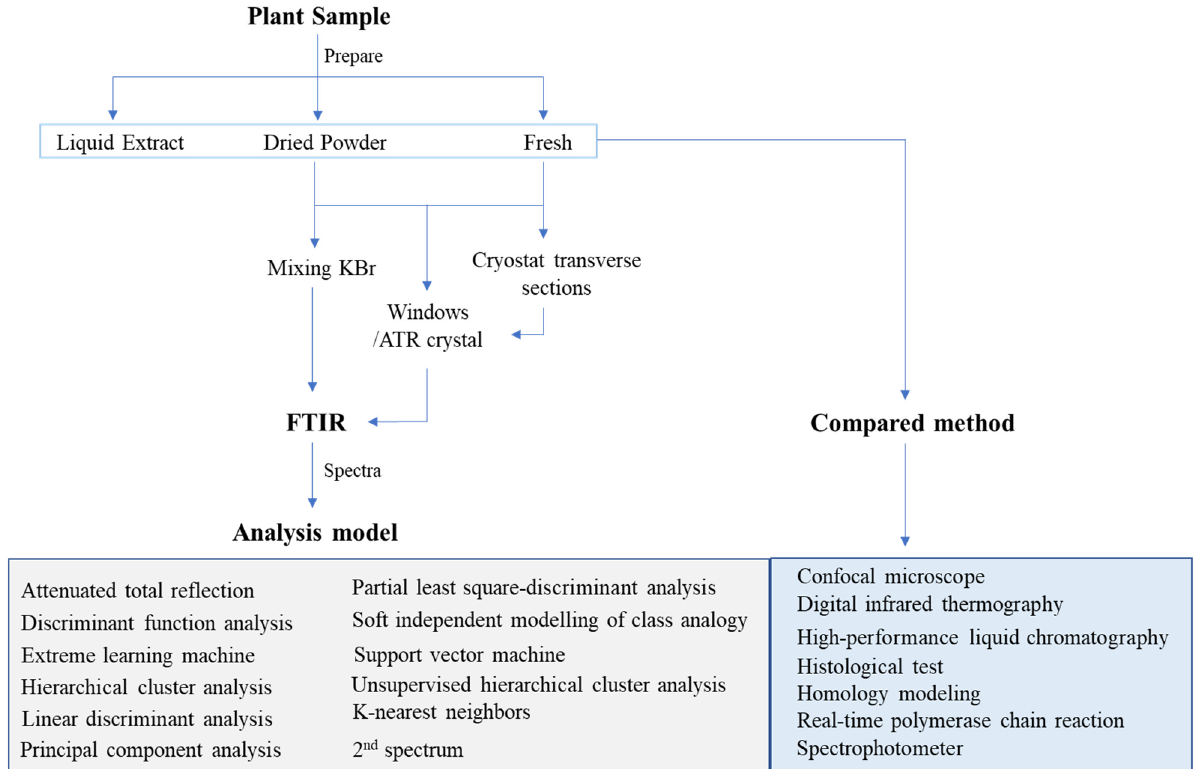
Figure 1. The research schematic for applying FTIR in plant disease.